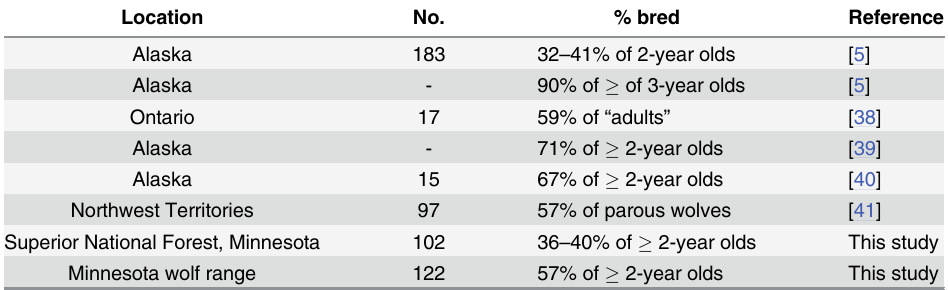
Table 8. Percentage of female wolves excluding pups and yearlings that bred in various